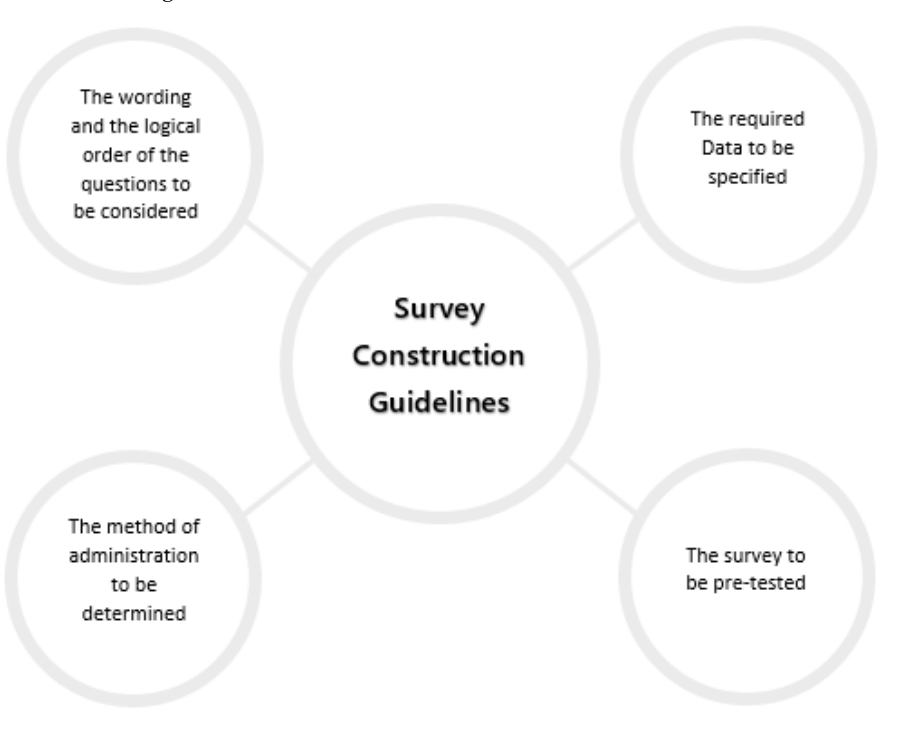
Figure 2. Survey construction guidelines.